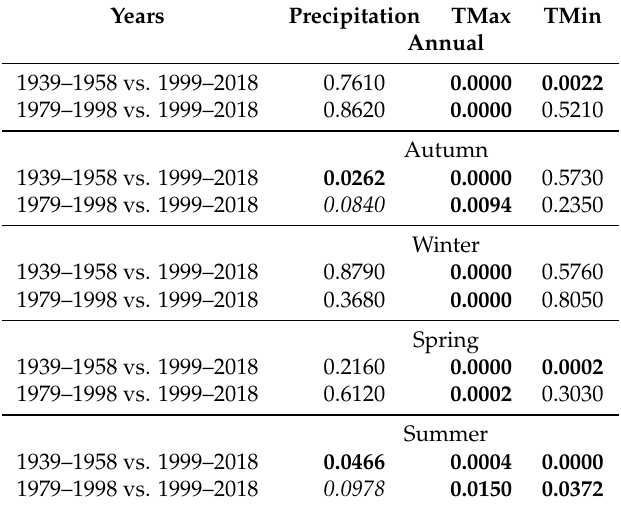
Table 3. p -values for the permutation test on the difference between the mean wet season precipitation, mean maximum temperature or mean minimum temperature between 1939–1958 and 1999–2018; and 1979–1998 and 1999–2018. Tests conducted used 5000 resamples. Text in bold face highlight statistical significance at the 95% confidence level, text in italics highlights statistical significance at the 90% confidence level. Years Precipitation TMax